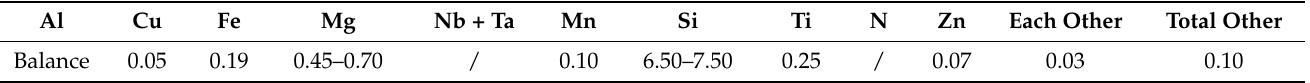
Table 1. Chemiacal composition (mass fractions in